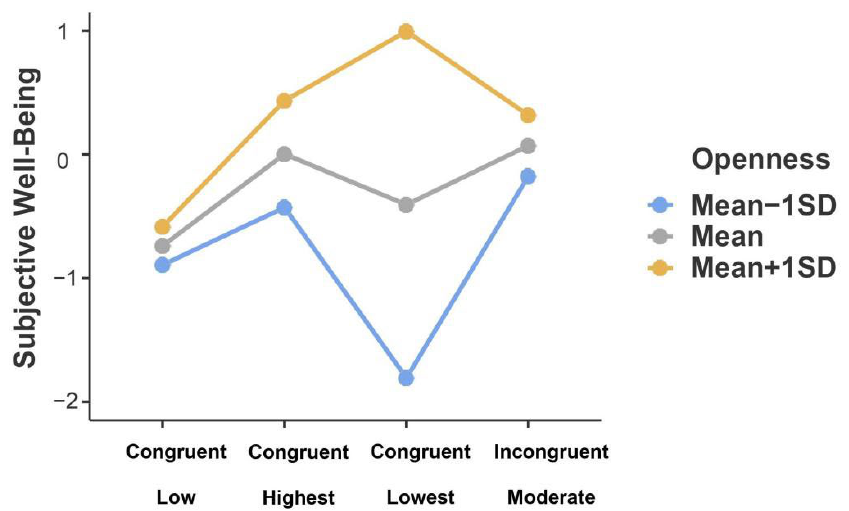
Figure 3. Interaction effect of warmth profiles and openness on subjective well-being in left-behind youth. Note . N = 246. Openness was divided into three levels based on mean: Mean − 1 SD, Mean, and Mean + 1 SD.